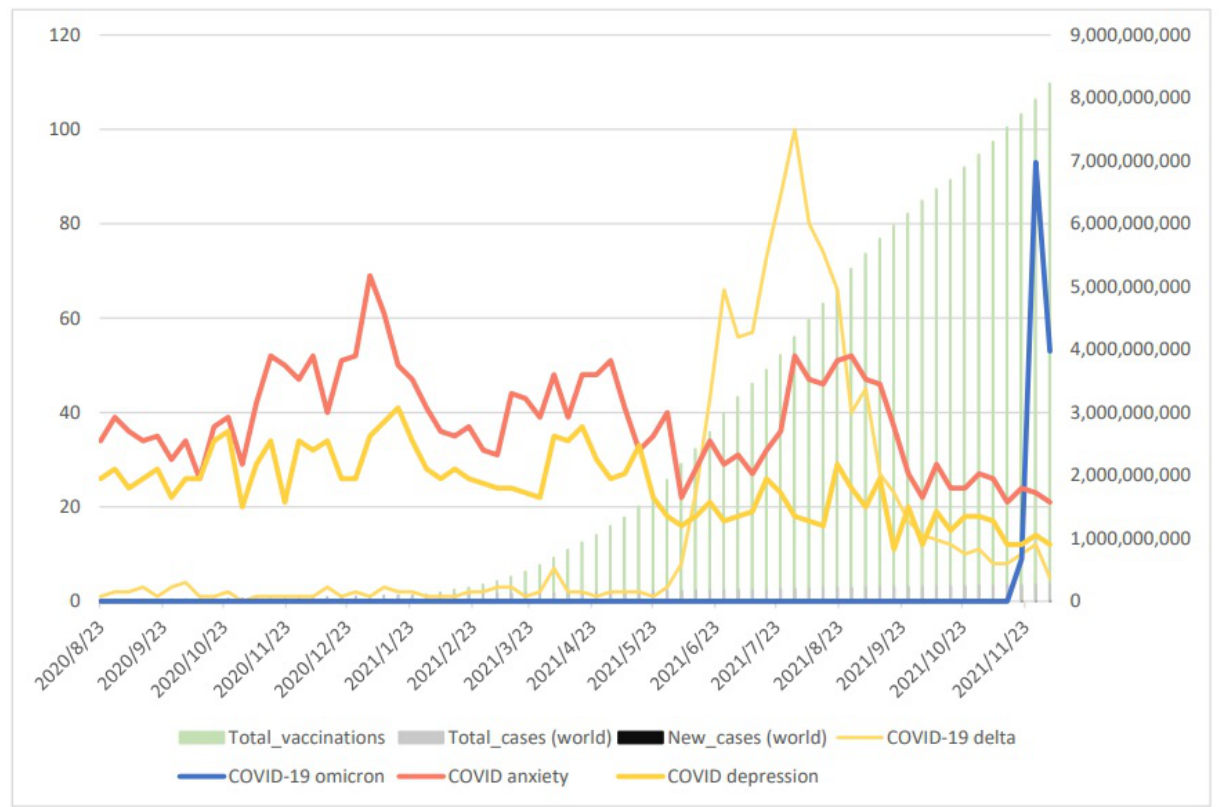
Figure 1. Display of Google Trend data for two major COVID-19 variants, i.e., Delta and Omicron, and COVID-19 anxiety and depression as well as for total and new COVID-19 cases. Normalized search data were obtained from Google Trend (100—high interest; 0—no or insufficient interest data) for the period from 23 August 2020 to 5 December 2021. COVID-19 case data were from JHU (John Hopkins University) CSSE COVID-19 Data (accessed 5 December, 2021). Table 2. The Pearson correlations among total vaccination, total cases, new cases, COVID-19 Delta, COVID-19 Omicron, COVID anxiety, and COVID depression.